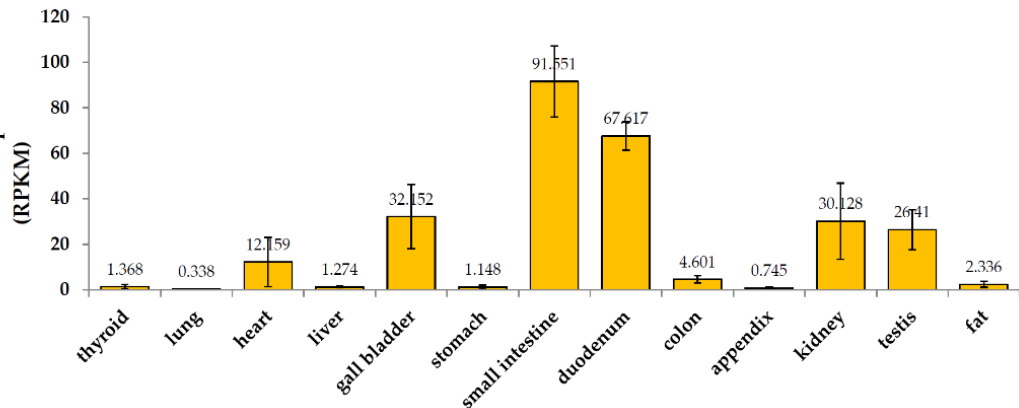
Figure 4. mRNA expression of ACE2 in healthy human tissues. Source: BioProject: PRJEB4337.